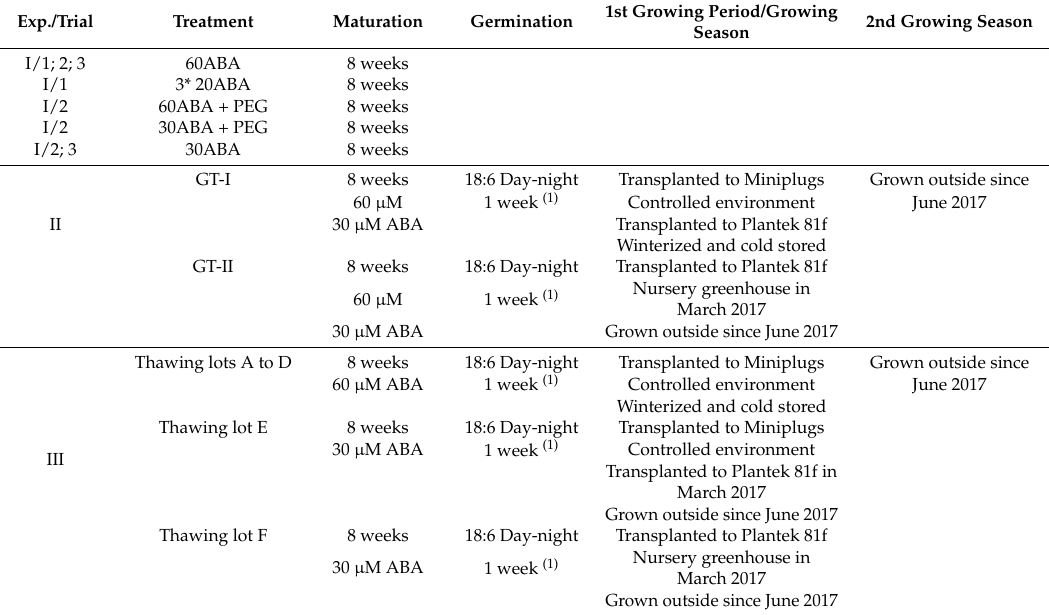
Table 1. Schematic description of experiments and treatments used in different phases of SE production in Experiments I to